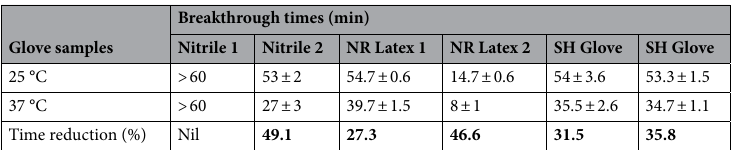
Table 3. Result of average breakthrough time of the glove samples at room temperature and 37 °C. The time reduction percentage are presented in bold to show the